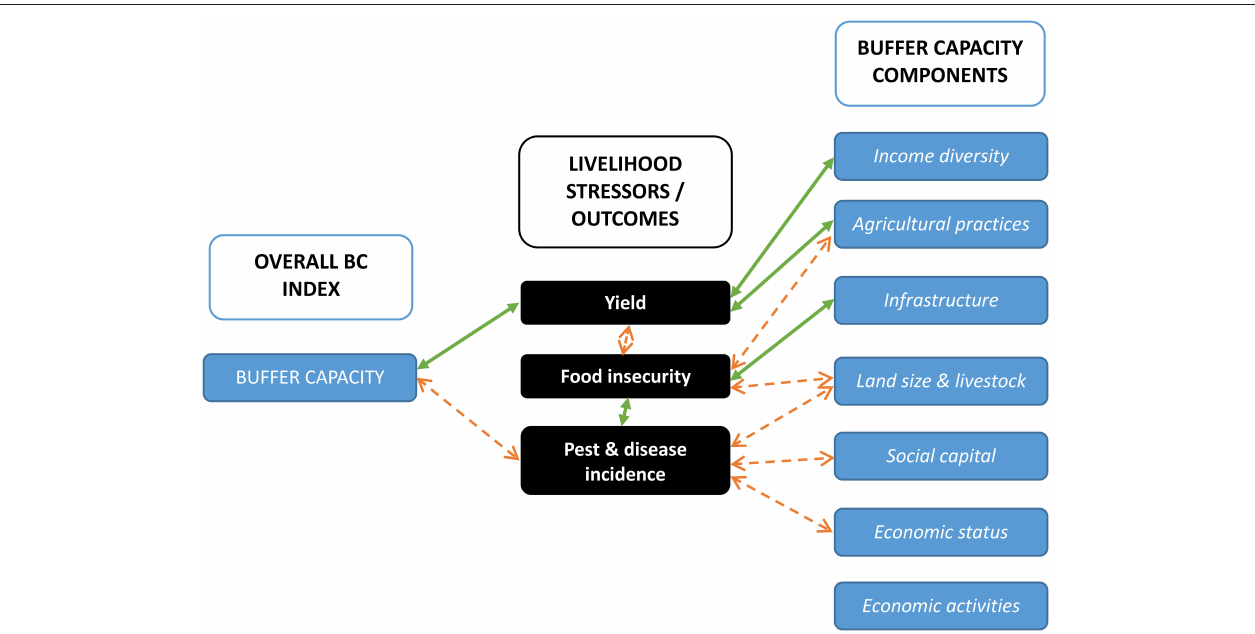
FIGURE 8 | Summary of significant positive (green arrows) and negative (red dashed arrows) correlations (r s ) between buffer capacity as well as its seven underlying components and the three variables: Yield, food insecurity, and pest/disease